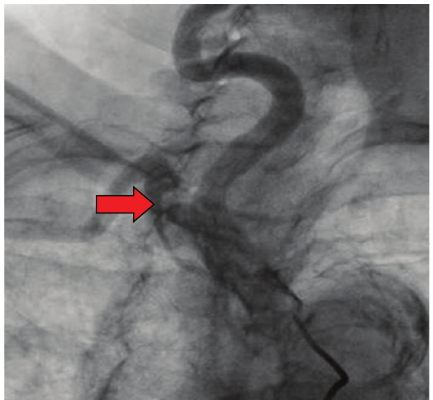
Figure 3: Selective angiography of the right brachiocephalic artery revealed 70% stenosis of the right subclavian